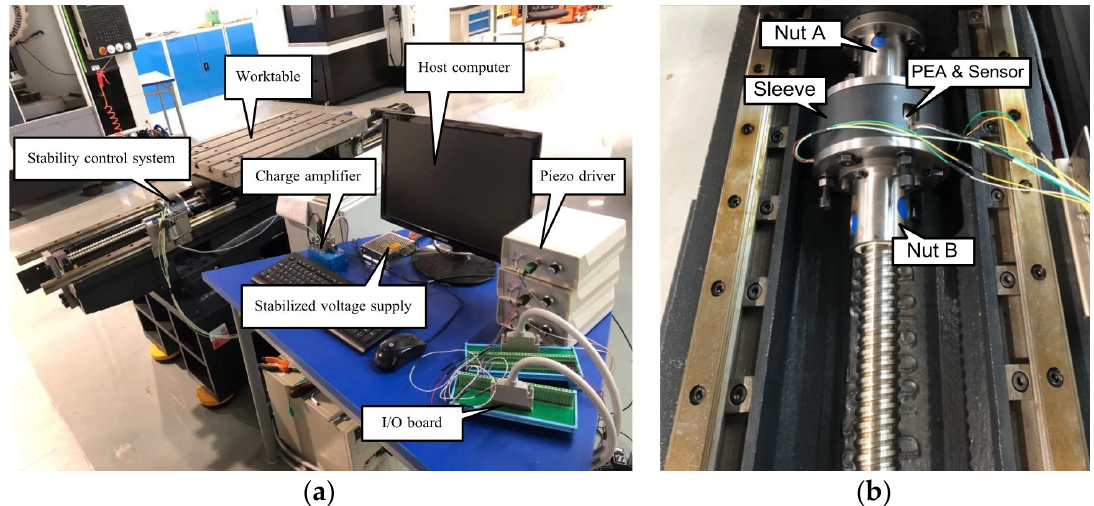
Figure 7. The experimental test rig: ( a ) overall configuration of the rig; ( b ) stability control system.